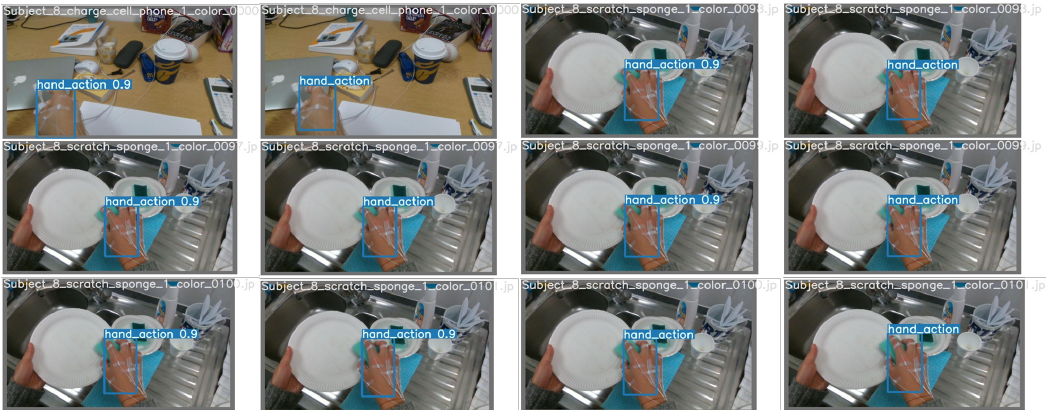
Figure 21. Illustrating some results of hand action detection and classification on the testing set of Conf .#123 of the FPHAB dataset when Thesh IOU = 0.5.